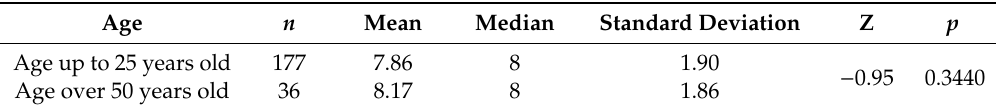
Table 13. The level of intensity of the motivation to undertake PA due to cheering in the 6th Poznan Half Marathon—depending on